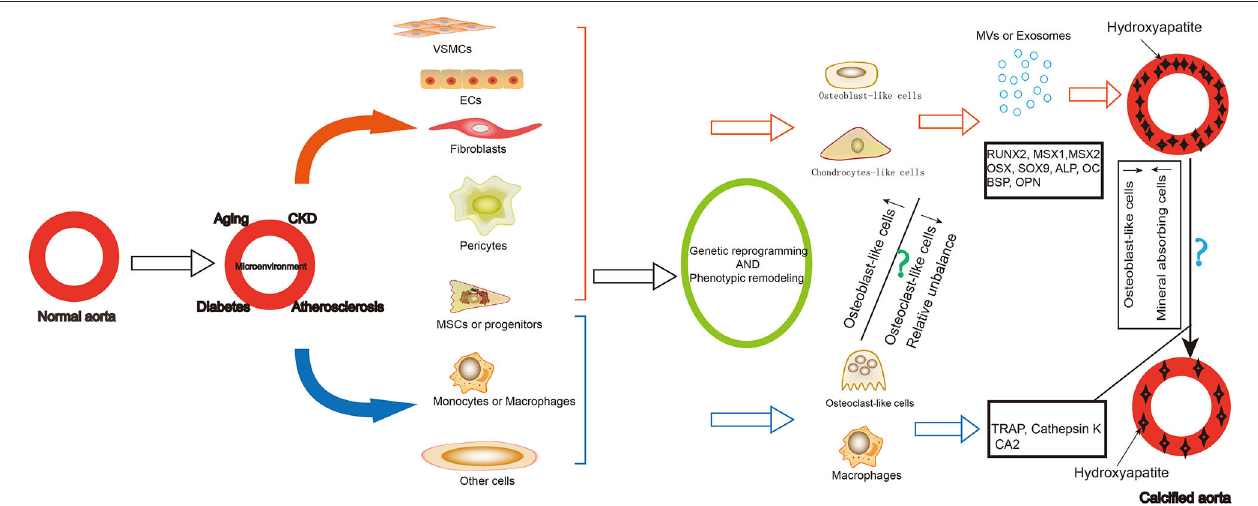
FIGURE 1 | Summary of the origin and role of osteoblast-like cells and osteoclast-like-cells in vascular calcification. Vascular calcification is common in older adults, patients with chronic kidney disease, diabetes, and atherosclerosis. During the formation of vascular calcification, many cells differentiated into osteoblast-like cells or chondrocytes-like cells, including VSMCs, ECs, fibroblasts, pericytes, MSCs and progenitors. They express osteoblastic differentiation transcription factors and bone matrix proteins as well as secrete exosomes and matrix vesicles contributing to the development and progression of vascular calcification. Some cells can also differentiate into osteoclast—like cells, including some MSCs or progenitors, macrophages. They play a role in demineralization of the vascular calcification. The reduction of osteogenic phenotype cells and the increase of mineral reabsorption cells may be a strategy for vascular calcification cell therapy. VSMCs, vascular smooth muscle cells; ECs, endothelial cells; MSCs, mesenchymal stem cells; MV, matrix vesicles; RUNX2, RUNX family transcription factor 2; MSX, msh homeobox; SOX9, SRY-related high mobility group-box gene9; OSX, Sp7 transcription factor; ALP, alkaline phosphatase; OC, osteocalcin; BSP, bone sialoprotein; OPN, osteopontin; TRAP, acid phosphatase 5, tartrate resistant; CA2, carbonic anhydrase 2.